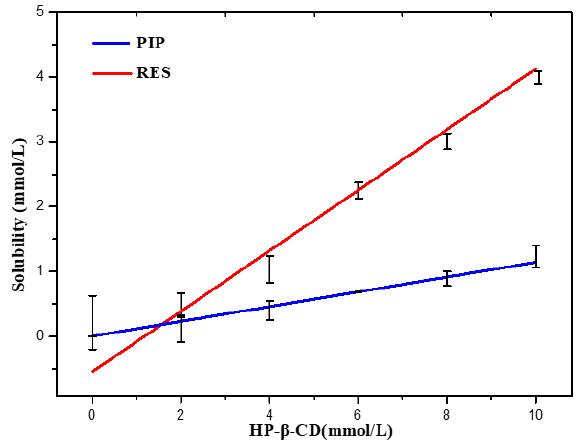
Figure 1. Phase solubility diagram of RES and PIP.